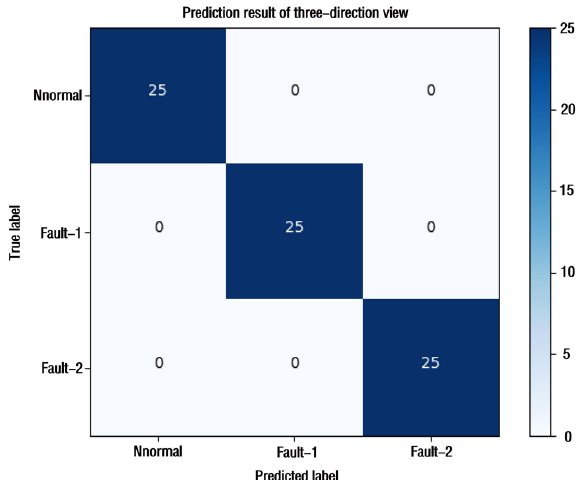
Figure 6. Confusion matrix of three-direction view.